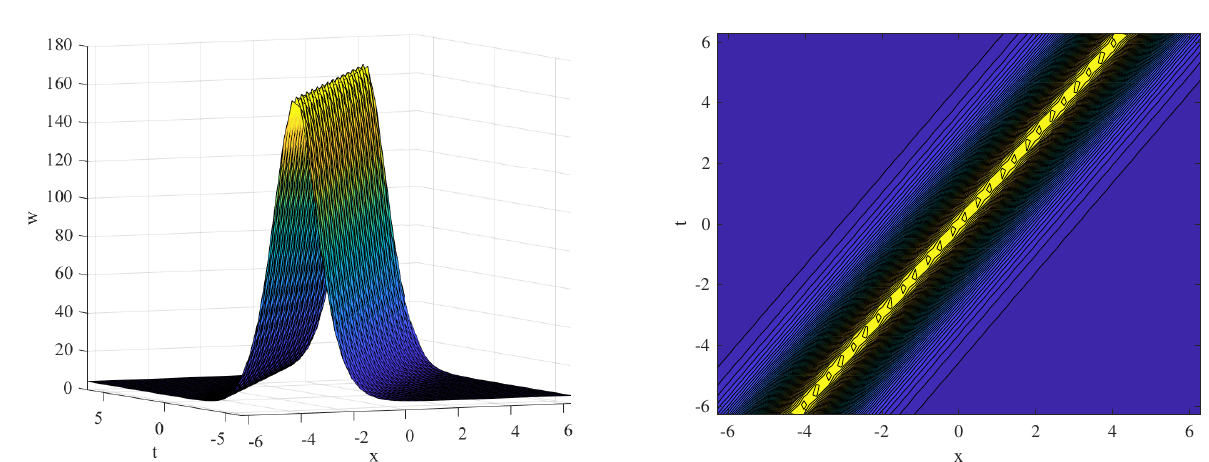
Figure 1. The behavior of solution (10) ( W 1 ( ξ )) under the parameters a 0 = a 1 = a 3 = 0, a 2 = 1, a 4 = − 20. The contour of this solution is shown in the right figure under the same parameters.